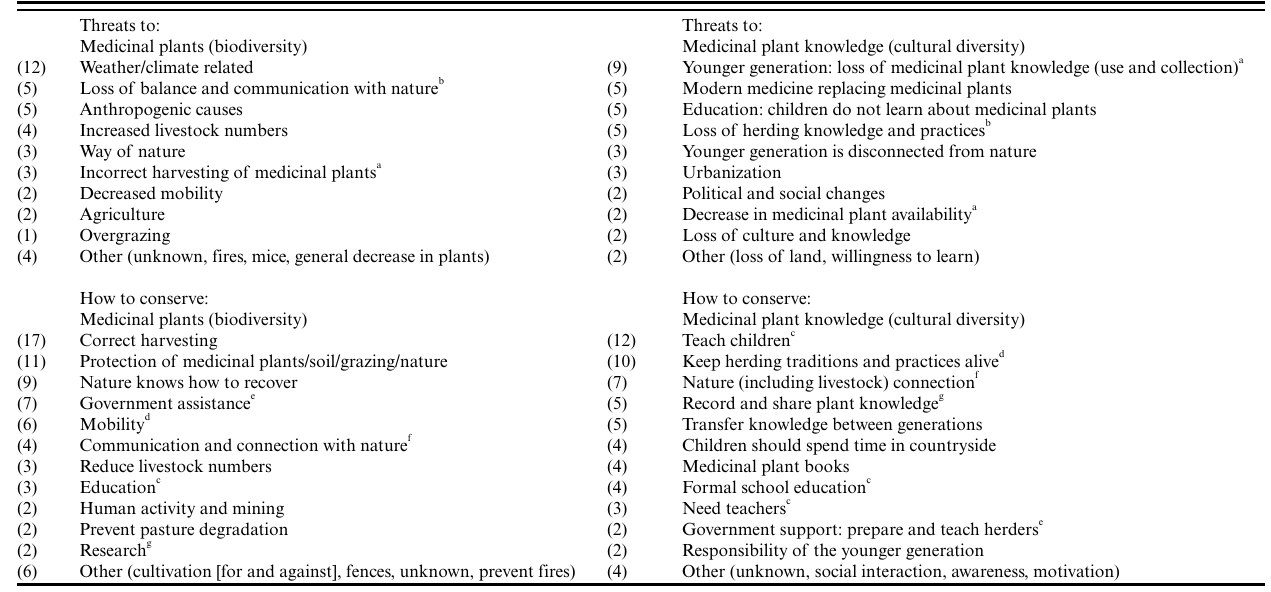
Table 3 . Co-occurrence of similar codes is indicated by corresponding letters in superscripts across the themes of “medicinal plants” and “medicinal plant knowledge” in the Mongolian pastoralist context. Groundedness values (in brackets) indicate the number of times each code was used throughout all interviews. Codes relate to perceived threats regarding the availability of medicinal plants and continuation of local medicinal plant knowledge as well as ideas around conserving this